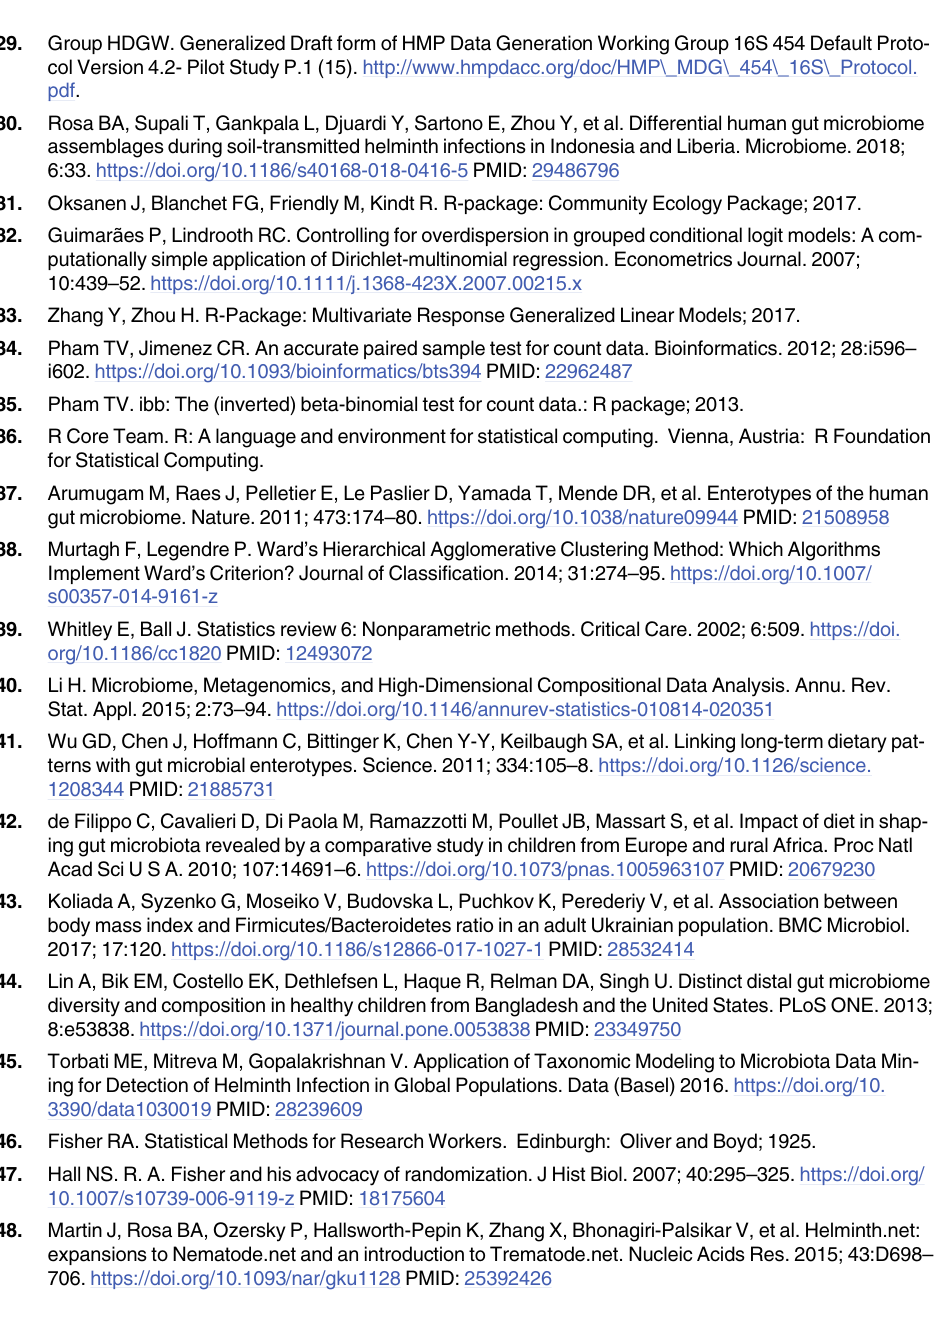
29. Group HDGW. Generalized Draft form of HMP Data Generation Working Group 16S 454 Default Proto- col Version 4.2- Pilot Study P.1 (15).